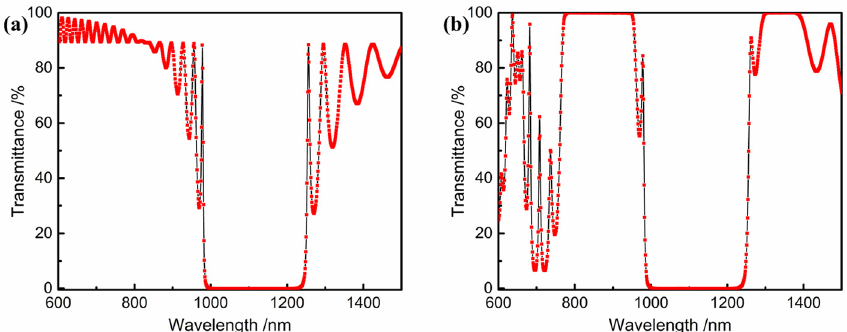
Figure 3. ( a ) The initial film system transmittance spectral curve and ( b ) the theoretically calculated transmittance spectral curve of multilayer optical coatings for the input surface.